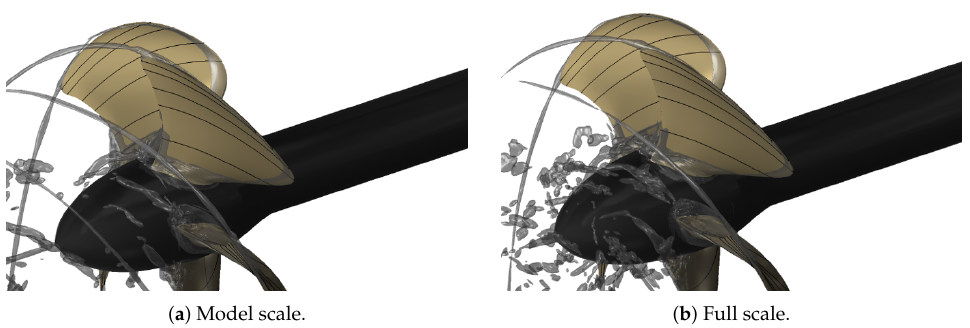
Figure 27. Comparison of the predicted cavitation patterns behind the propeller and on the pressure side of the blades for the PPTC Case 2 in model- and full-scale conditions. Both results are from